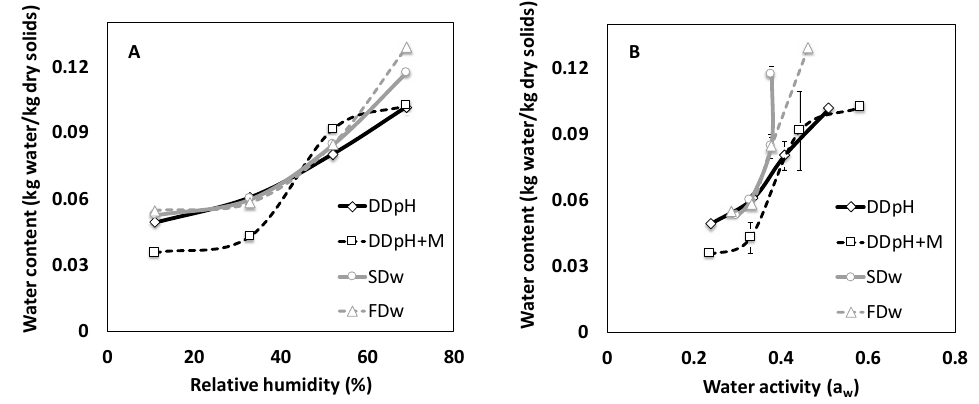
Figure 1. ( A ) Water content for thylakoid powders produced in di ff erent ways as a function of relative humidity in surrounding environment after 8 months of storage in controlled atmosphere with di ff erent relative humidity. ( B ) Water content for thylakoid powders produced in di ff erent ways as a function of water activity in the powders after 8 months of storage in controlled atmosphere with di ff erent relative humidity. DD pH = drum-dried powder produced by the pH method, DD pH + M = drum-dried powder produced by the pH method with addition of maltodextrin, SD w = spray-dried powder produced by the water method, FD w = freeze-dried powder produced by the water method.